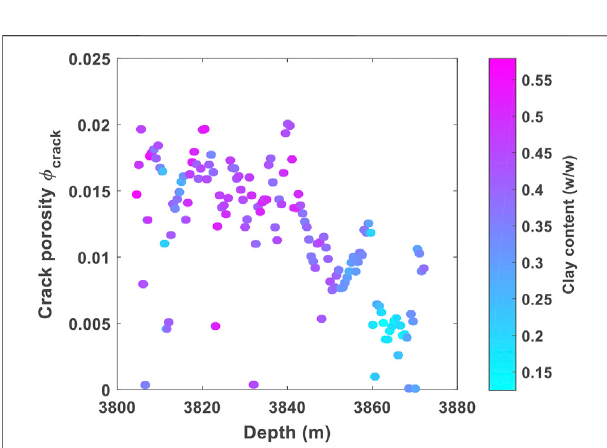
FIGURE4| Cross-plotbetweenthecrackporosityandburialdepth.The data points are color-coded by clay content.